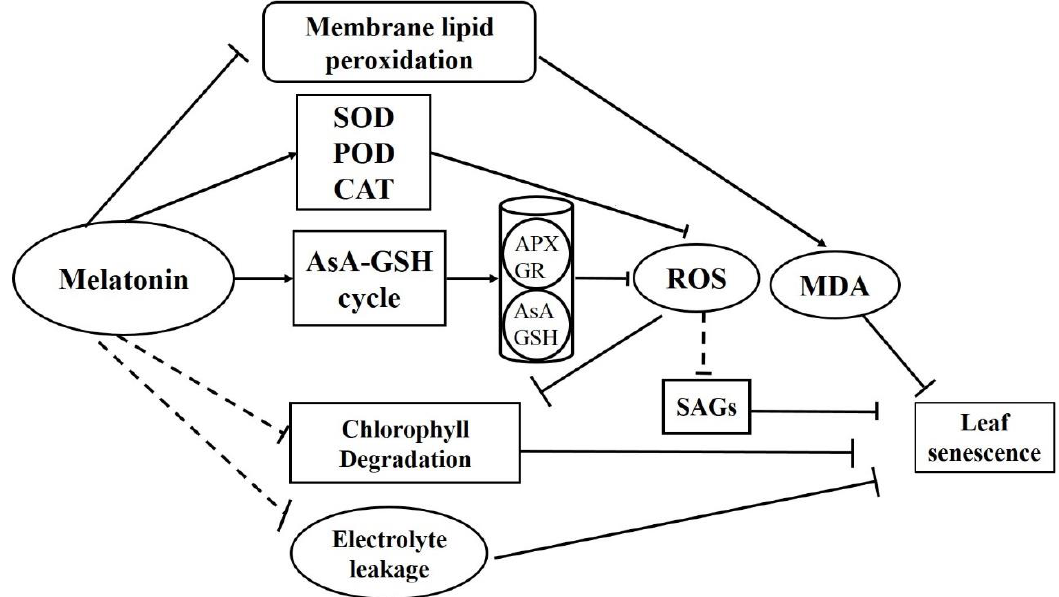
Figure 7. The model of MT treatment on the effect of dark-induced grapevine leaf senescence. The broken lines represent the unknown molecular mechanism.